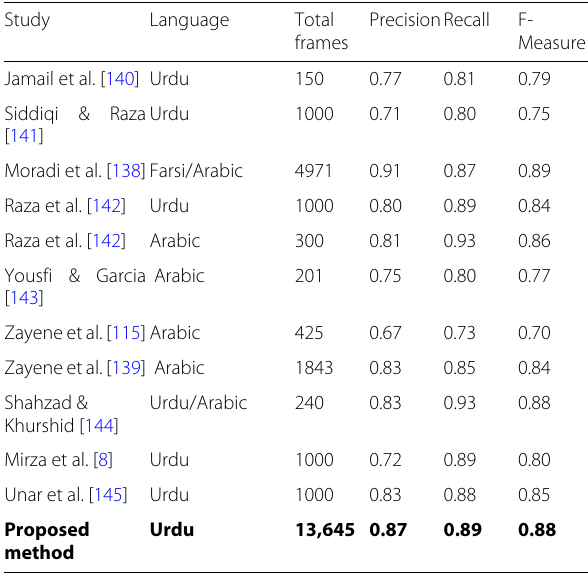
Table 4 Text detection performance comparison with other techniques